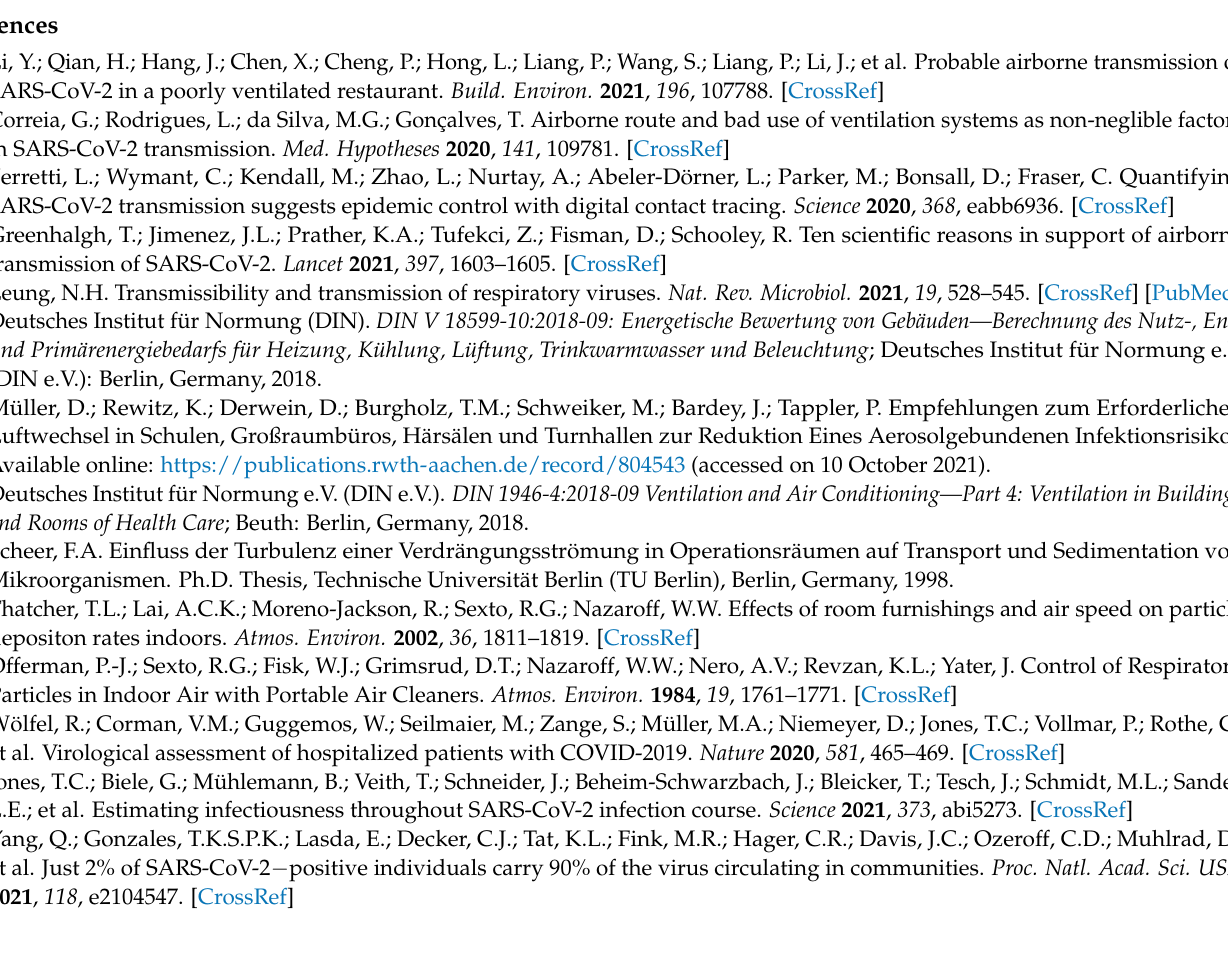
divided by the critical dose. t, time of stay. q pers —specific volume flow per person. Q b,in —inhalation flow rate of the susceptible persons. f M —mask efficiency considering the inhalation and exhalation efficiency. R s —number